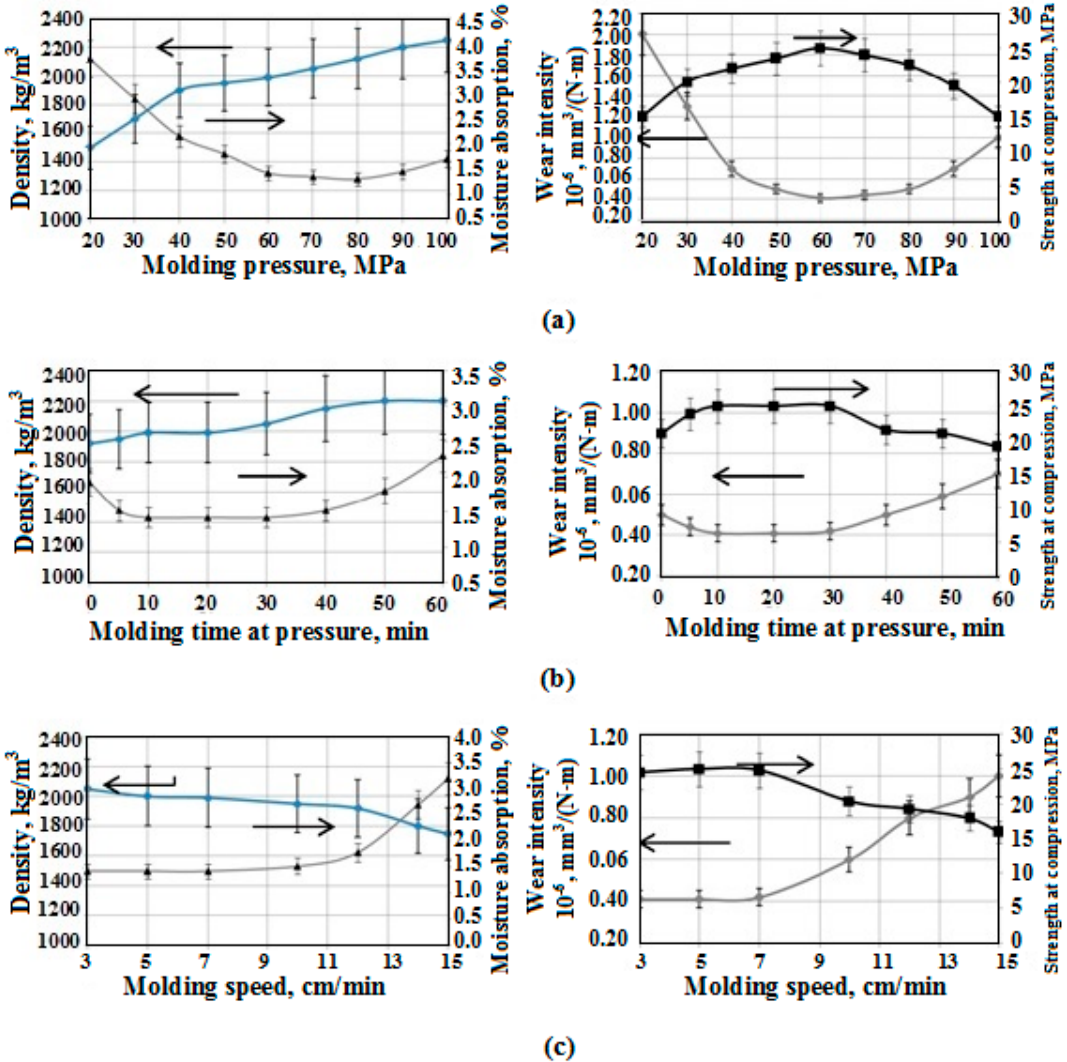
Figure 7. Dependences of CFRP properties on: molding pressure ( a ); time of molding under maximum pressure ( b ); and molding speed ( c ).